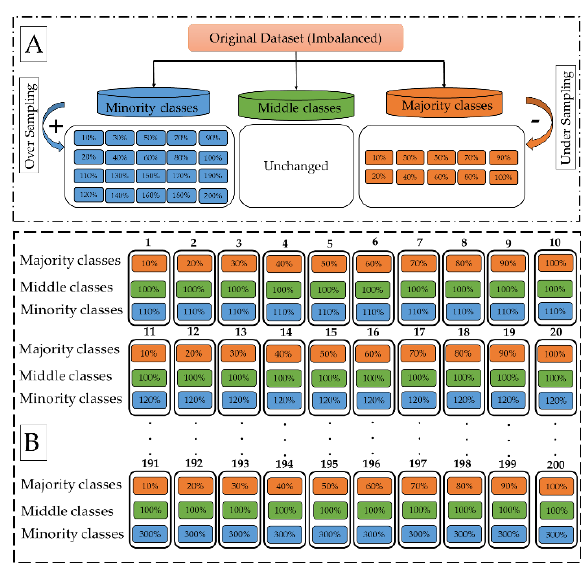
Figure 4. ( A ) The schematic representation of separating the original imbalanced data into different classes. ( B ) An overview of the defined fractions for rebalancing the original reference dataset.